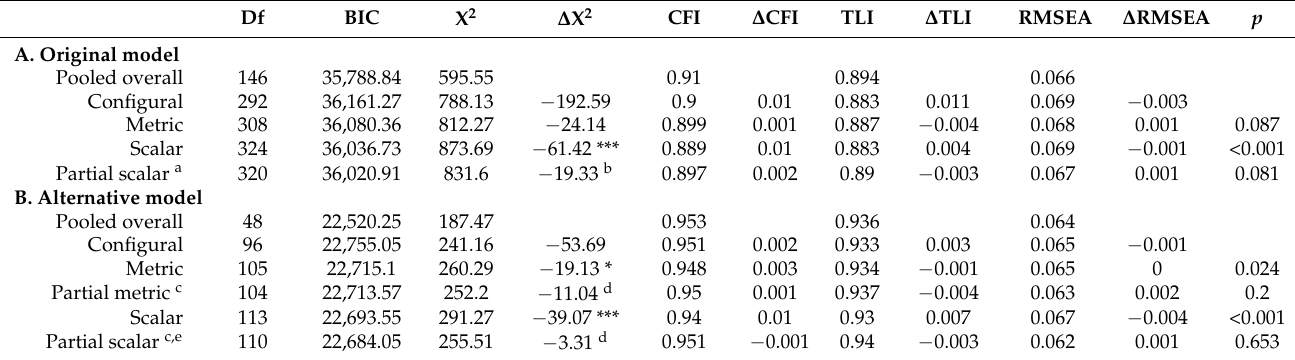
Table 3. Gender-based measurement